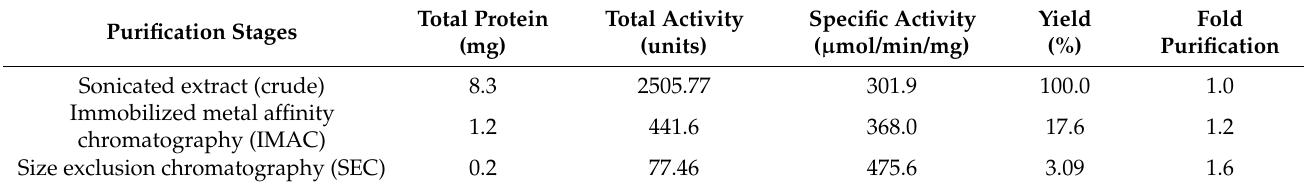
Table 1. Purification steps and total activity, specific activity, percentage yield, and fold purification for recombinant Pk -LDH. In total, 15 mL of cellular extract was processed after sonication and 1.5 mL of the purified sample was obtained. Purification